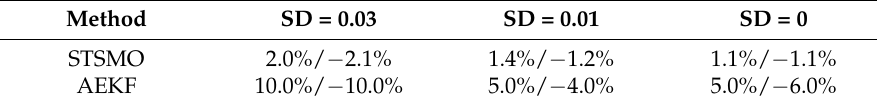
Table 5. The SOC estimation error range with different amplitude